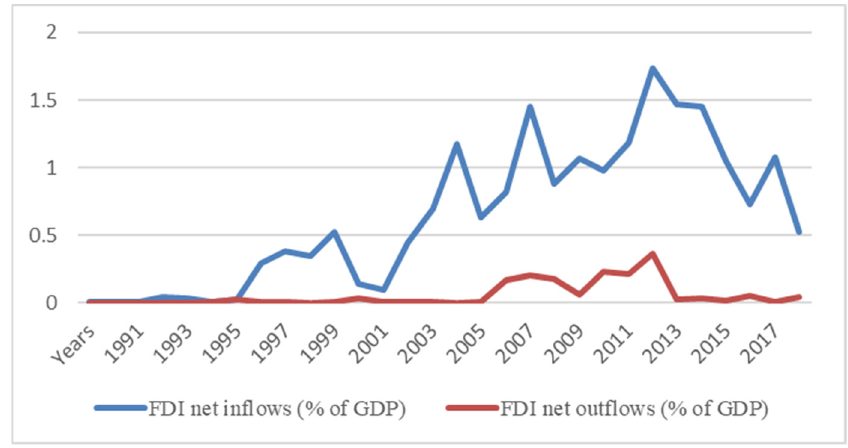
Figure 1. The movement of FDI inflows and outflows in Bangladesh.